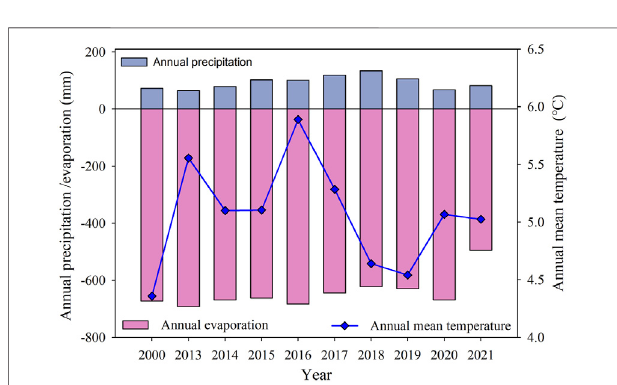
FIGURE 10 | Change in temperature, precipitation, and evaporation from 2000 to